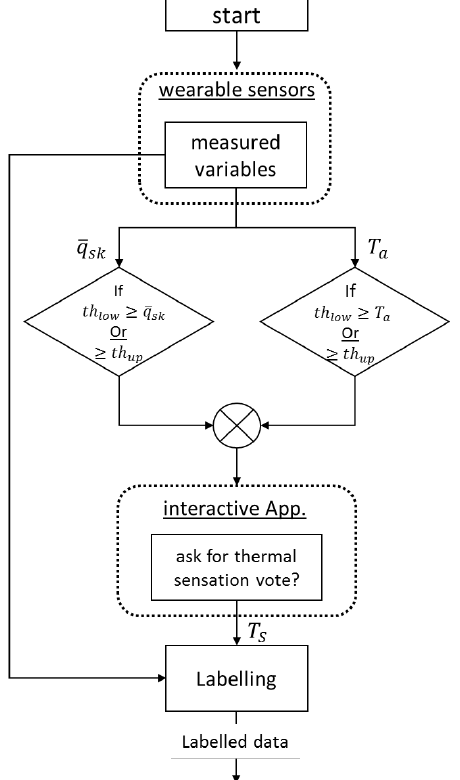
Figure9. Figure 9. Flowchart represents the main workflow of the streaming data acquisition and labeling process.